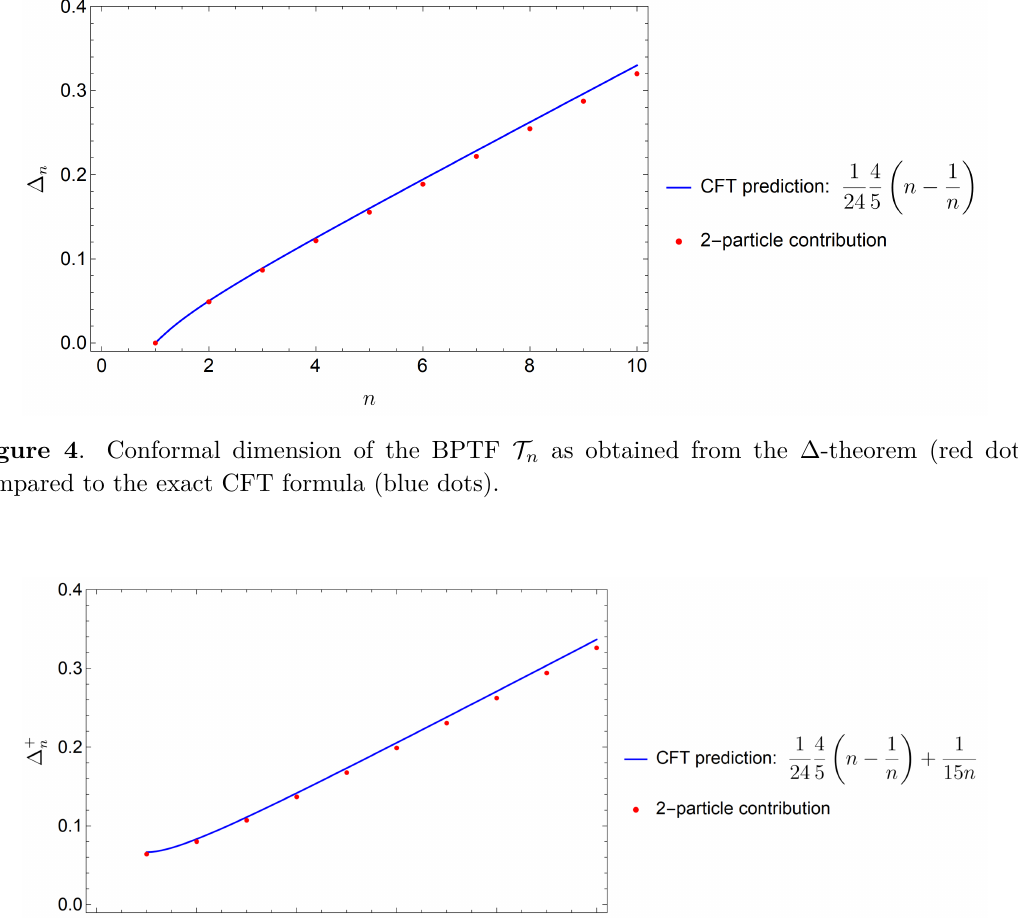
as obtained from the ∆ -theorem (red dots) n